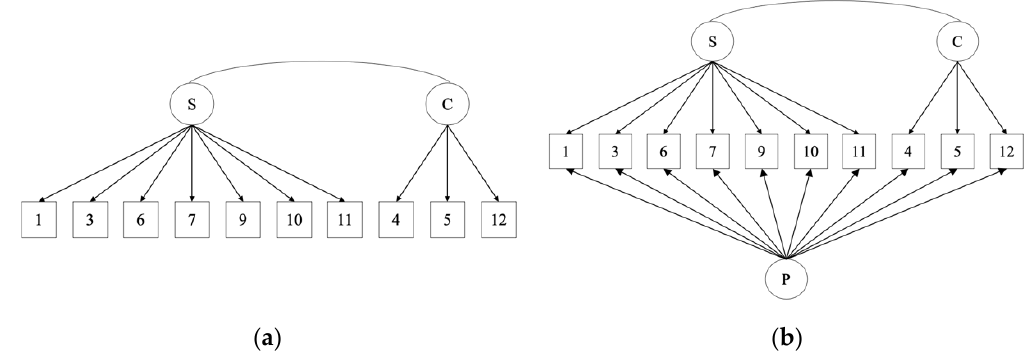
Figure 2. Tested factor structures of the CPQ; ( a ) Two-factor CPQ; ( b ) Bifactor CPQ; Note: S = perfectionistic strivings, C = evaluative concerns, P = general perfectionism.